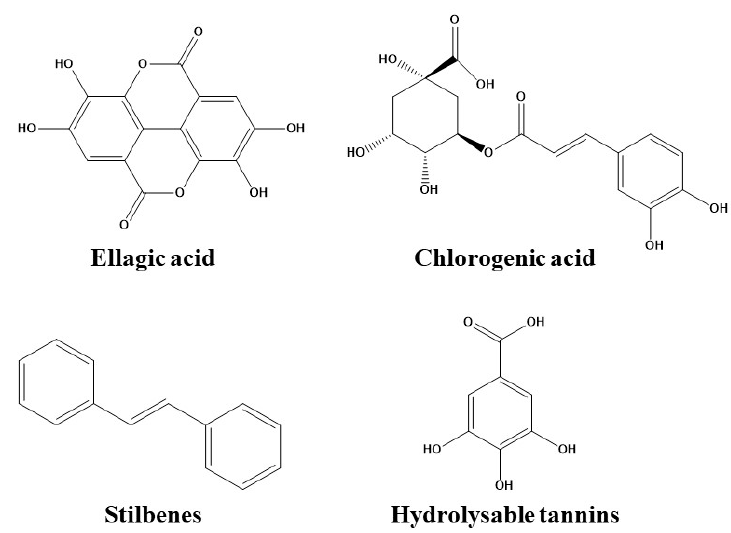
Figure 2. Chemical structure of representative phenolic acids. General chemical structure of stilbenes and hydrolysable tannins.